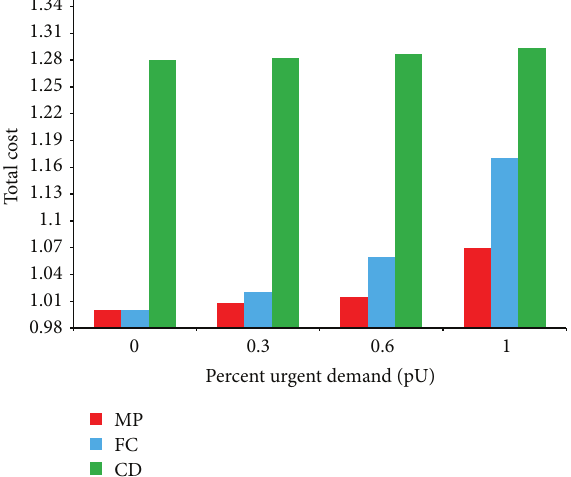
Figure 8: Relative total cost against percent urgent demand (pU) under various approaches (MP, CD, and FC), problem set 2. Note: total costs are represented relative to the cost at percent urgent demand equal to 0% under MP policy.